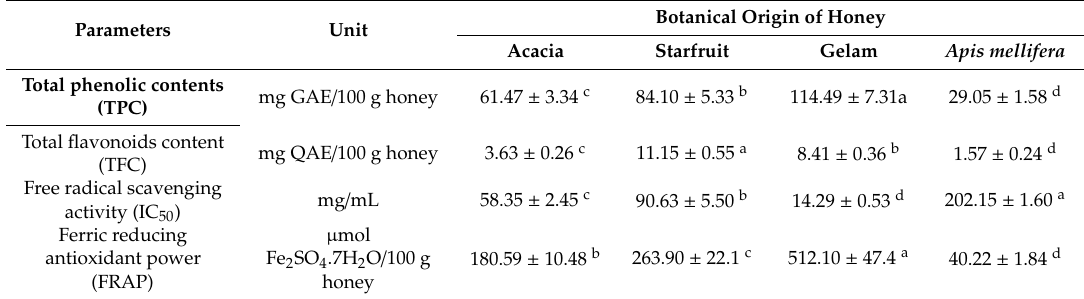
Table 4. Antioxidant properties of honey samples from di ff erent botanical